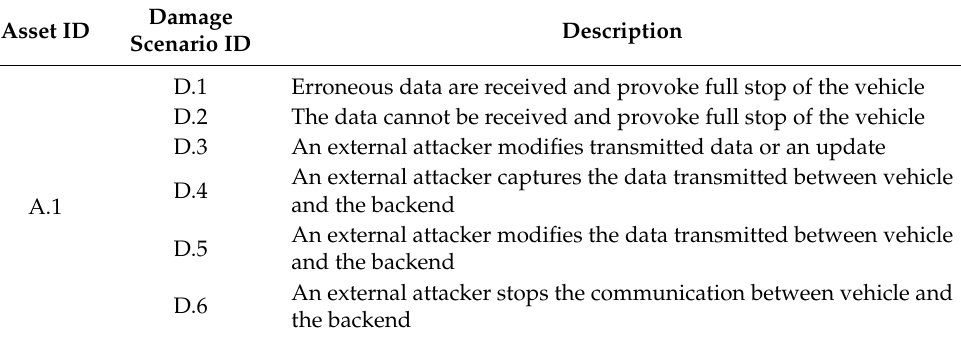
Table 1. Sample threat scenarios for 3G/4G antenna.